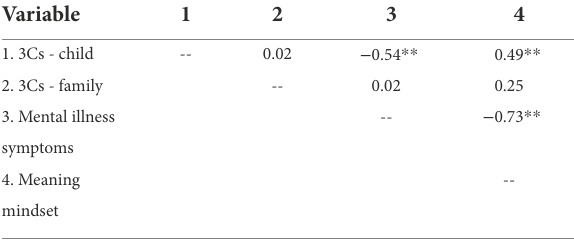
TABLE 3 Correlations between the 3Cs factors, mental health, and meaning mindset (French).